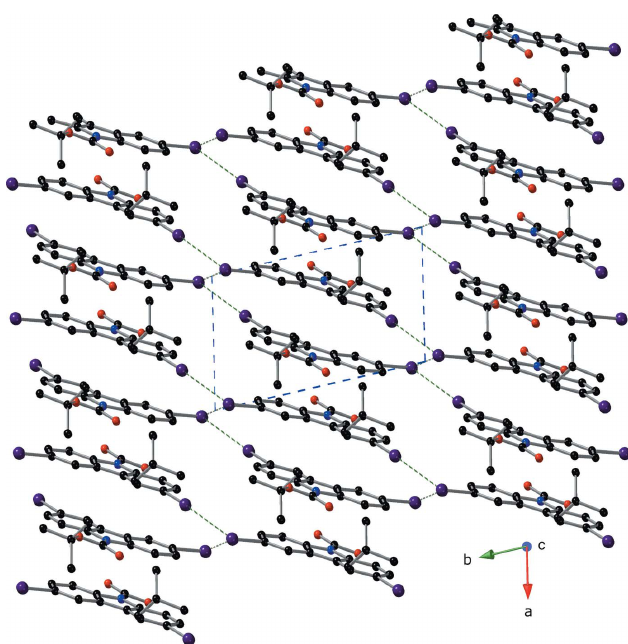
Figure 4 A view down the c axis showing the supramolecular pillars found in the crystal of compound I as well as the I—I interactions (depicted as green, dashed lines) that hold them together using a ball-and-stick model with standard CPK colors (I = purple). The unit cell is drawn with a blue, dashed line and the (cid:2) — (cid:2) interactions are not shown for